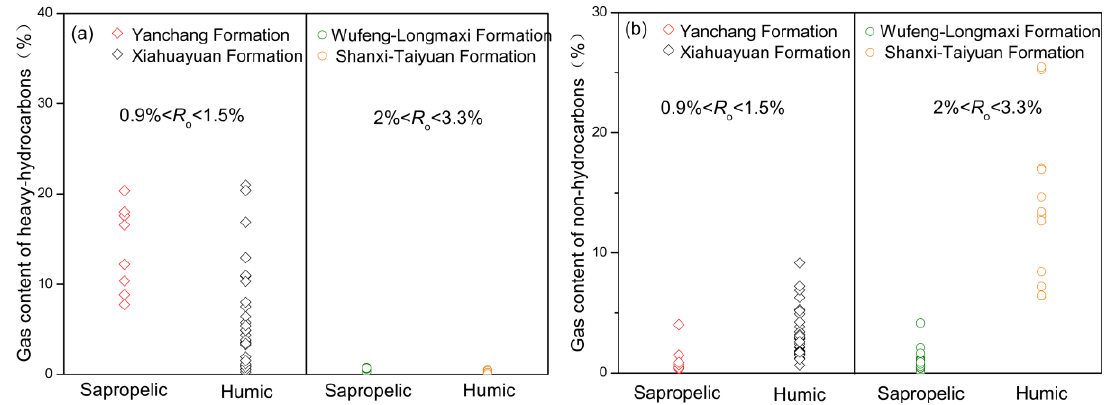
Figure 5. Molecular characteristics of shale gas generated from sapropelic source rocks and humic source rocks (all data were collected from [4,63], and our study). ( a ) Gas content of heavy-hydrocarbons generated from sapropelic source rocks and humic source rocks. ( b ) Gas content of non-hydrocarbons generated from sapropelic source rocks and humic source rocks.